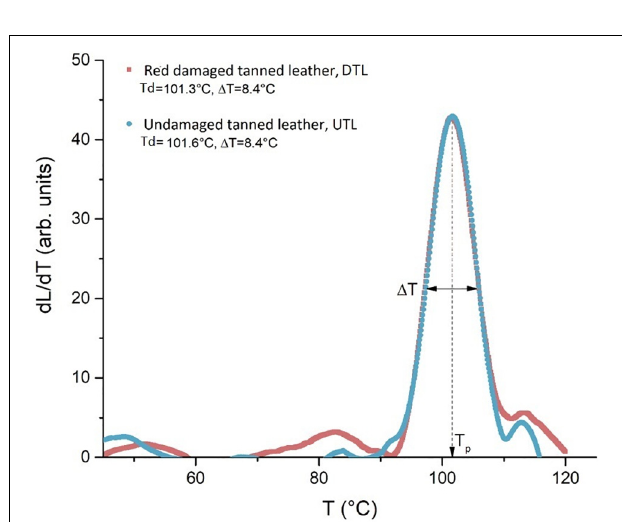
FIGURE 7 | The plot of the quantity dL/dT describes the intensity of the denaturation process as a function of temperature: the similar profile shown by the LTA curves indicates an analogous structural stability of the collagen in red damaged (DTL) and undamaged tanned leathers (UTLs).